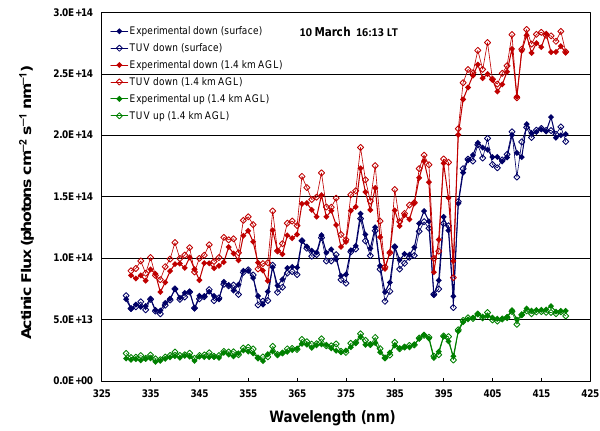
Fig. 6. Spectral variation of the measured and calculated actinic flux at surface and at 1.4km (a.g.l.) (downwelling and upwelling) for 10 March 2006 at 16:13 local time. PBL altitude at this moment was 3km